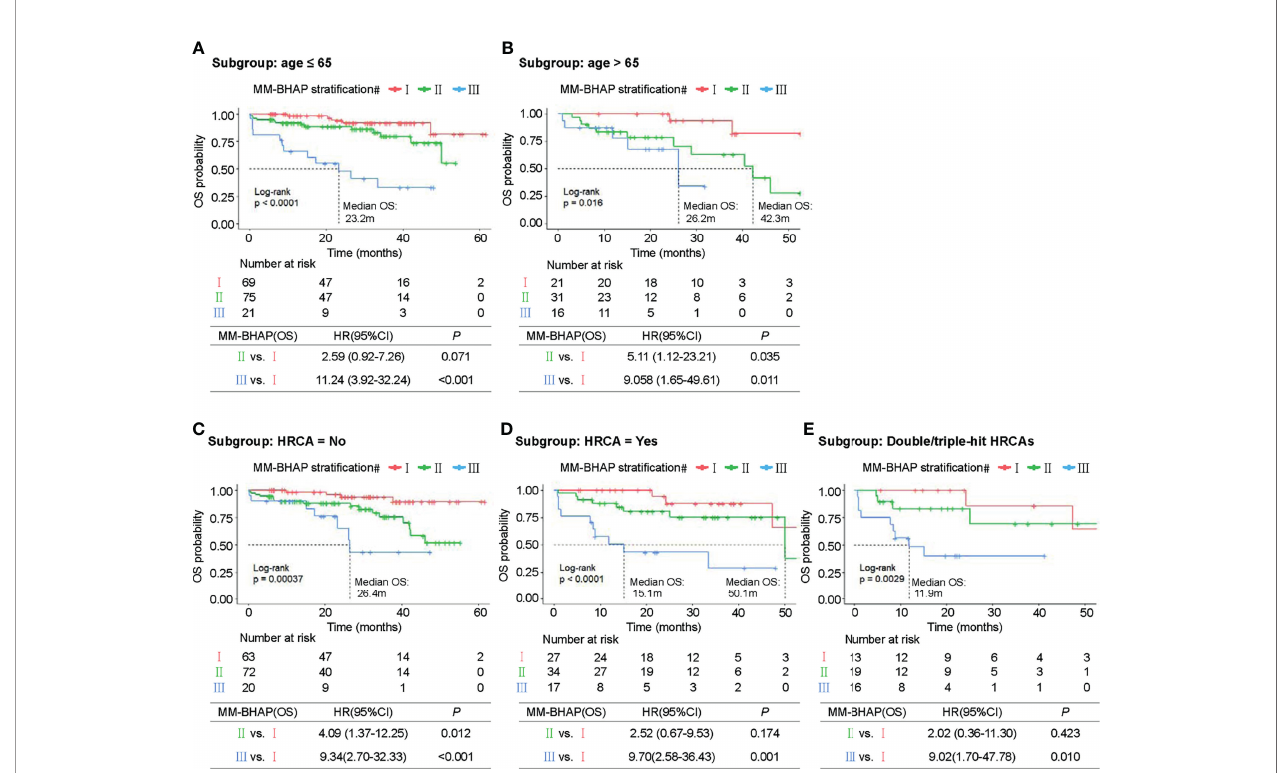
FIGURE 4 | Kaplan – Meier survival curves of speci fi c subgroups strati fi ed by the MM-BHAP strati fi cation in the development cohort. OS curves in the subgroups with different characteristics of age (A, B) and HRCA (C – E) were